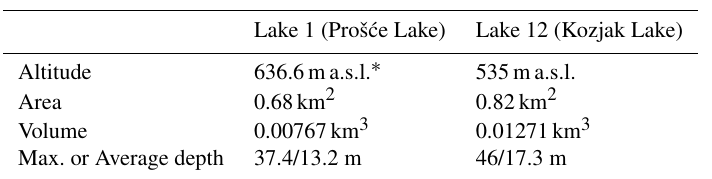
Figure 1. Location of Plitvice Lakes (red bubble; source: © Google Maps) (a) ; closer look at the entire lake system (b) ; Lake 1 (c) , and Lake 12 (d) . Locations of the lake temperature measuring points P1 ( ϕ = 44 . 8676 ◦ N, λ = 15 . 5981 ◦ E, height of the lake surface 636ma.s.l.) and K1 ( ϕ = 44 . 8902 ◦ N, λ = 15 . 6038 ◦ E, 535ma.s.l.), and meteorological measuring site M ( ϕ = 44 . 8811 ◦ N, λ = 15 . 6197 ◦ E, 579ma.s.l.) are shown with yellow circles. Panels (b) – (d) show composite pictures of the lake bathymetries and the digital orthophoto images (DOF: http://www.bing.com/maps/?v=2&app=60526, last access: 3 December 2020, Print Rights – Under the Microsoft ® Bing™ Maps Platform APIs’ Terms of Use). Table 1. Characteristics of the studied